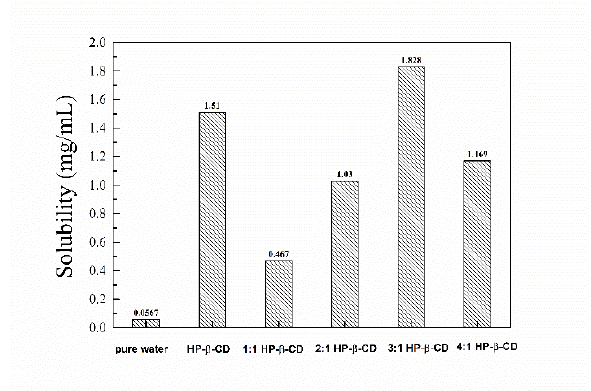
Fig.5. Effect of Urea-HP- β -CD in Different Proportions on VA Solubility.